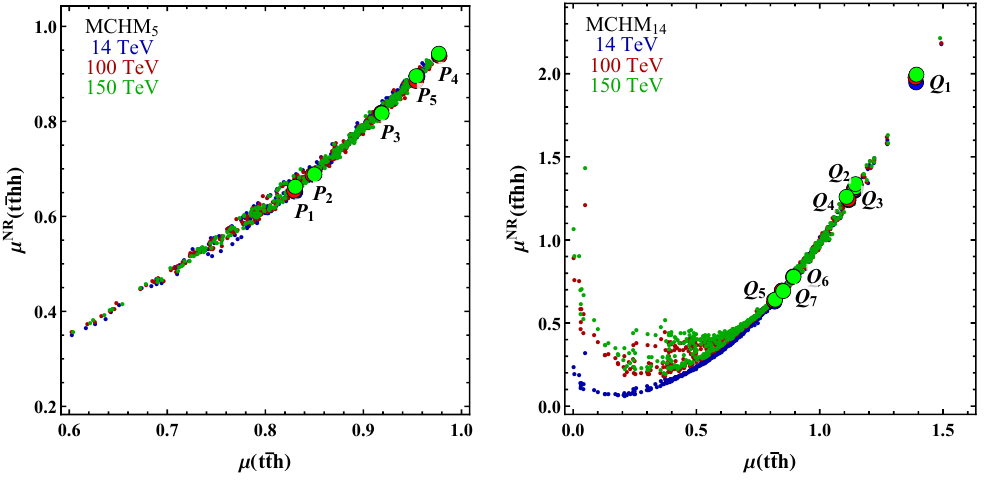
Figure 10 . Correlation between the normalized tth and non-resonant tthh cross sections, for 14 and 100 TeV CM energies. The left (right) plots correspond to the MCHM 5 (MCHM 14